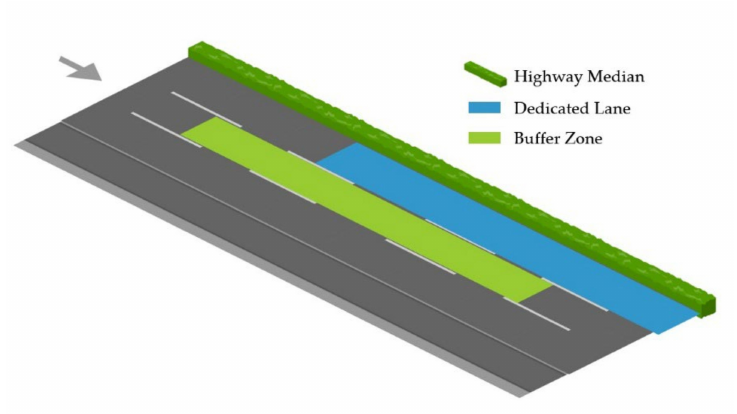
Figure 1. The layout of the dedicated lane and the buffer